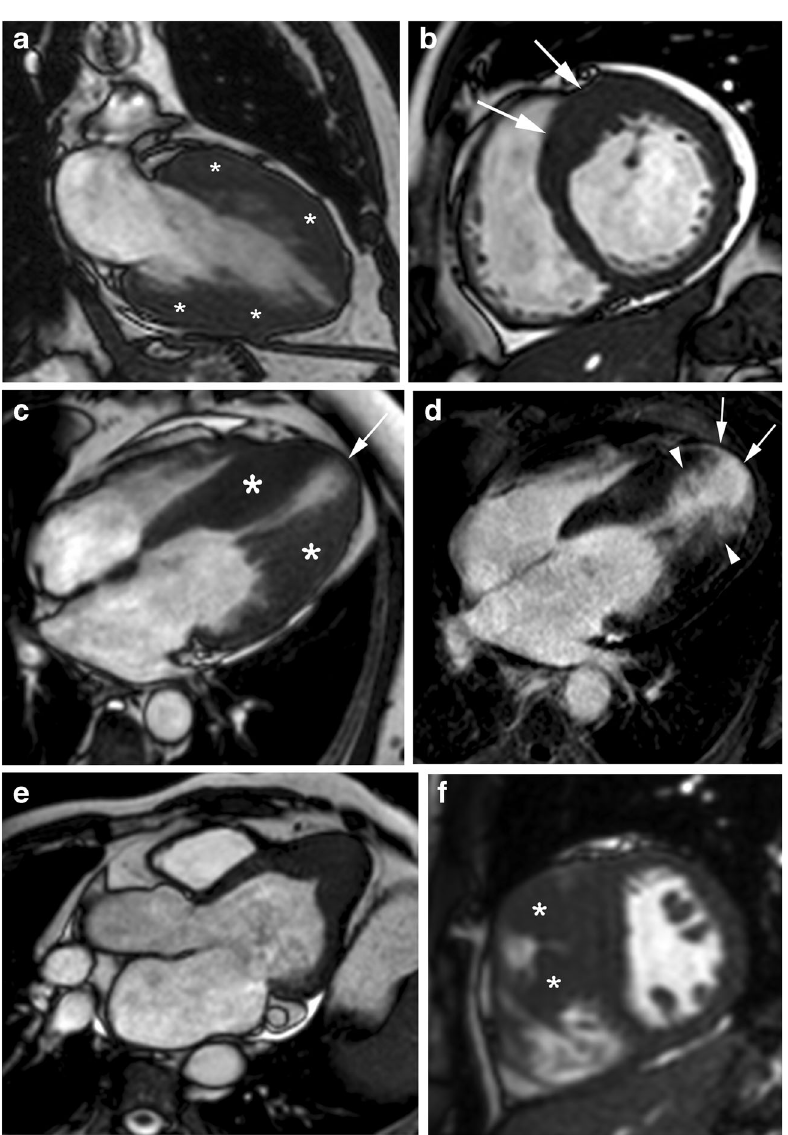
Fig. 4 Distribution of myocardial hypertrophy in classic HCM phenotype. a , 56-year-old man with symmetric myocardial hyper- trophy. End-diastolic two-chamber SSFP cine MR image shows diffuse and symmetric LV wall hypertrophy (asterisks); b , 43- year-old man who presented with palpitations. Short-axis SSFP cine MR image at end-diastole shows asymmetric septal wall hy- pertrophy (arrows); c , 57-year-old man with severe dyspnea. End- diastolic four-chamber SSFP cine MR image demonstrates a B dumbbell ^ configuration of the LV cavity with midventricular myocardial thickening (asterisks), marked muscular midcavity sys- tolic constriction and a thin-walled apical aneurysm (arrow). d ,